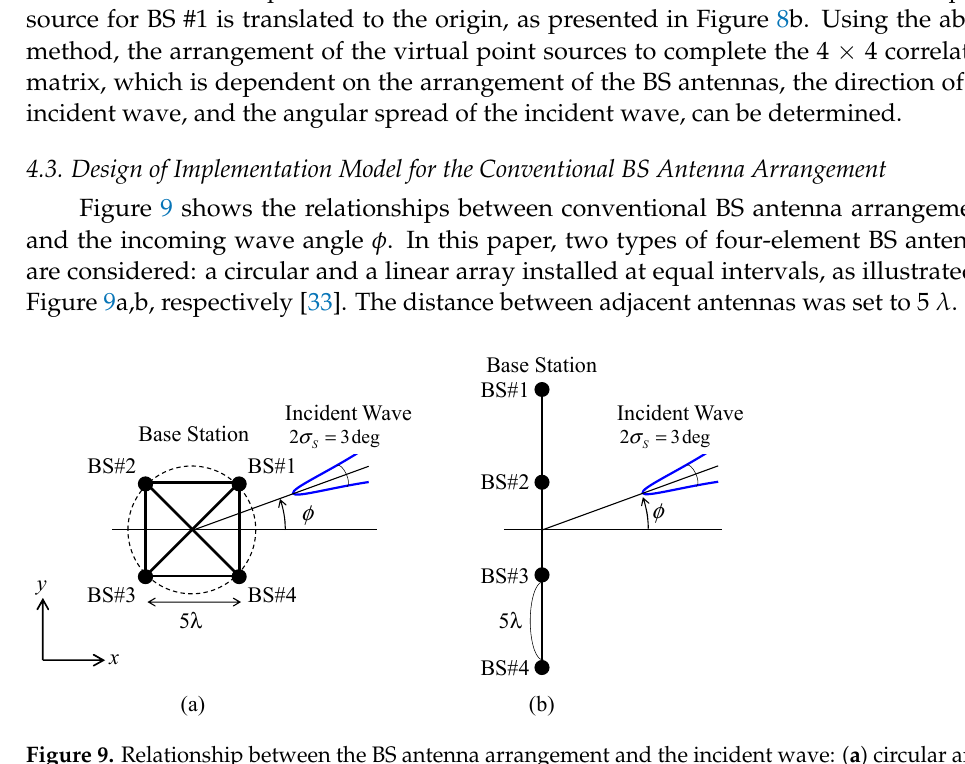
Figure 9. Relationship between the BS antenna arrangement and the incident wave: ( a ) circular array; ( b ) linear array.